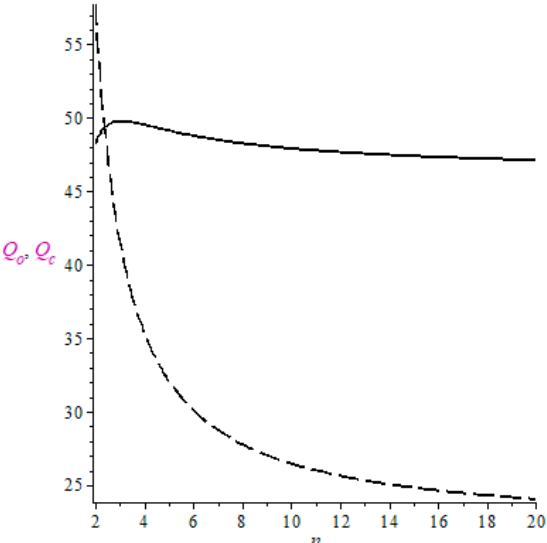
Figure 1. For the calibration, we used the following parameter values: q = 0.8, A = 20, β = 0.09, and α = 0.43 .